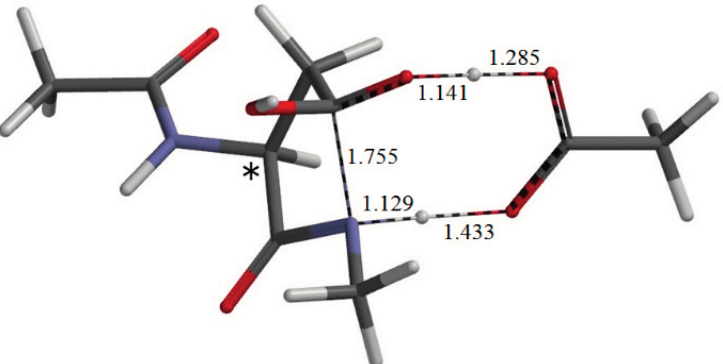
Figure 5. The geometry of the transition state TS-1 of the first step (cyclization) ( φ = − 162°, ψ = − 150°, χ 1 = 115°). The distances of forming and breaking bonds are shown in Å. The asterisk (*) indicates the α carbon.